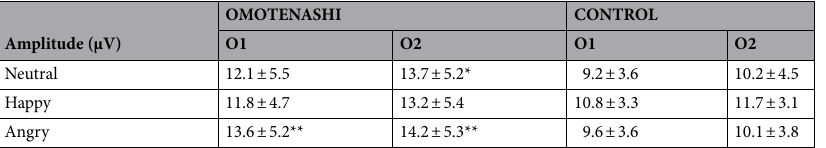
Table 3. Maximum amplitude (baseline-to-peak) of P100 at O1 (left) and O2 (right) for Neutral, Happy, and Angry stimulus conditions in OMOTENASHI and CONTROL. Data are presented as the mean and standard deviation for each group. *p < 0.05: comparison with CONTROL. **p < 0.01: comparison with